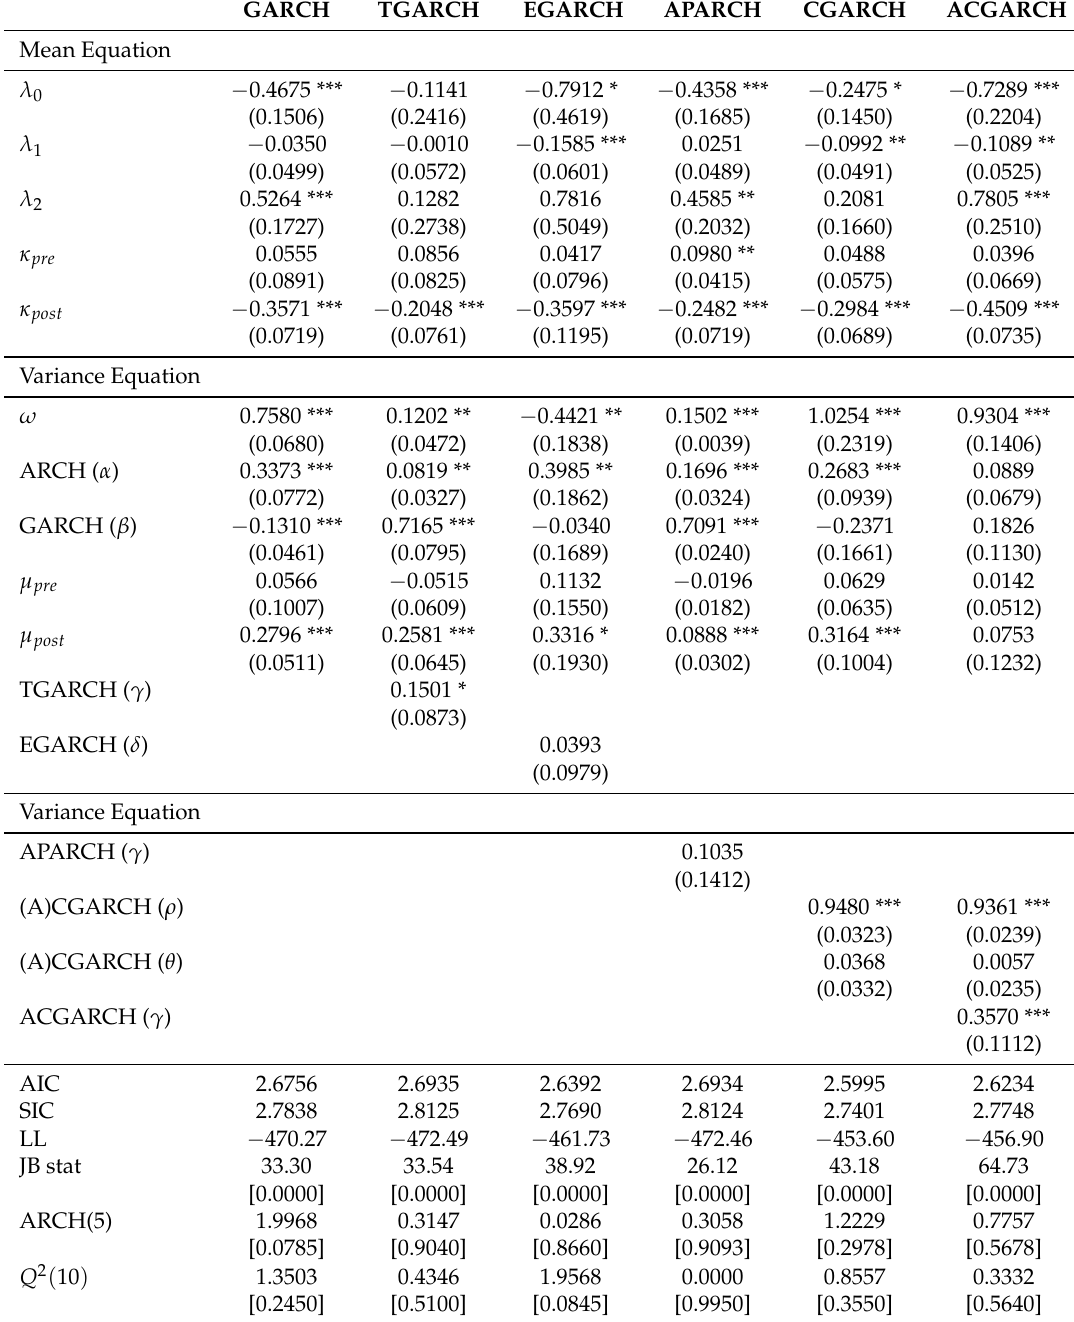
Table A5. GARCH-M Tests for Ethereum for the sample of 360